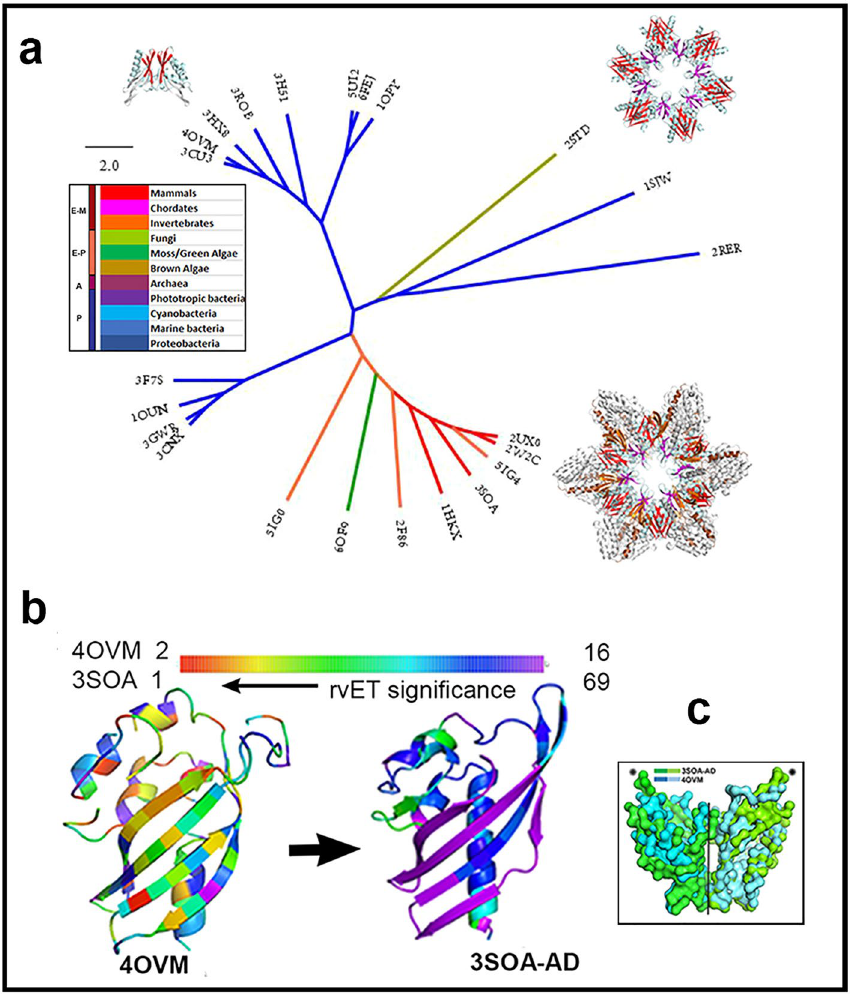
Figure 4. CaMKII phylogenetics (from 3D Structures). ( a ). Tree of 23 crystal structures of the CaMKII-AD homologs (color-coded by phyla) based on DALI scores. ( b ). The evolutionary trace (EV trace) for structures of an ancient bacterial enzyme (40VM.PDB) versus human CaMKIIα (3SOA.PDB). 3D Views in Supplementary Videos S9–S10. ( C ). Conservation of the dimer contact (RMSD = 0.69 nm). Source listed in Table